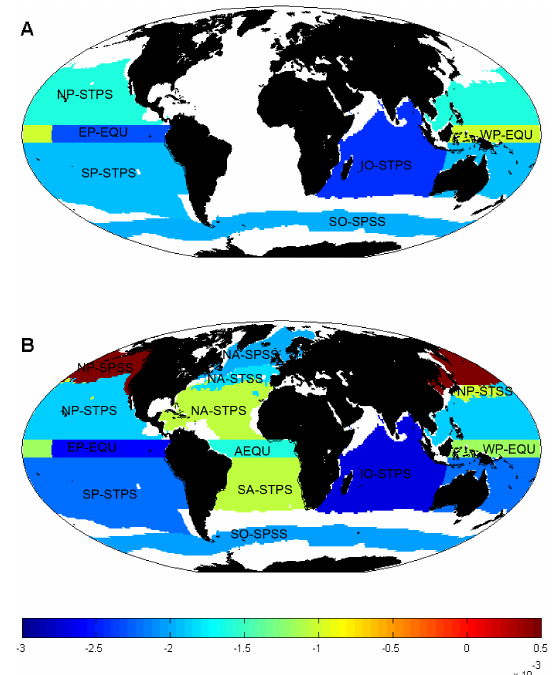
Figure 1. A map of the Fay and McKinley (2014) biomes which have (a) a statistically significant pH trend in the period 1981–2011, and (b) the biomes with a statistically significant pH trend in the period